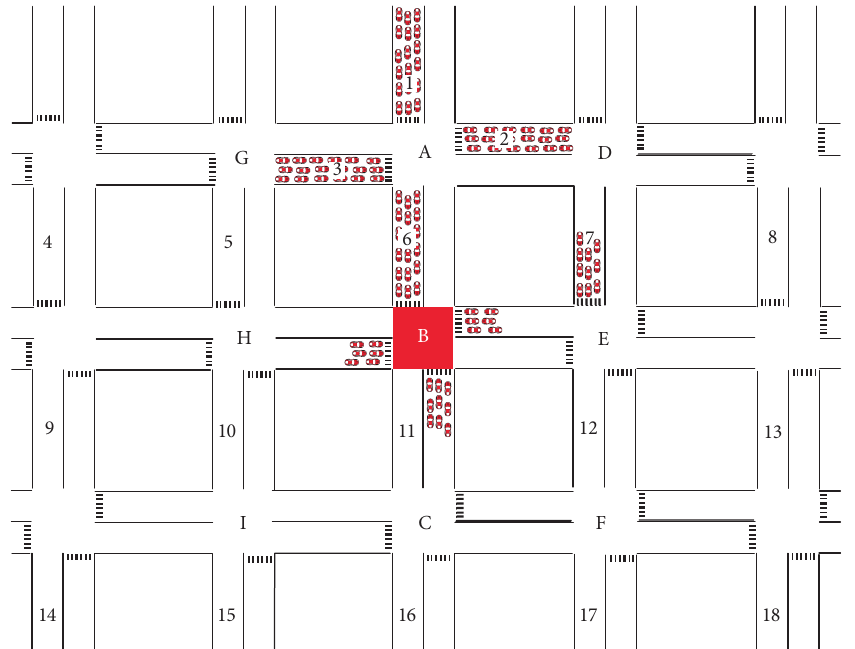
Figure 16: Suppose this network for ETL application. This network has a traffic jam on junction ( B ). As can be seen, node numbers 1, 2, and 3 are traffic jam providers of traffic jam accrued on junction ( B ). Using the ELT, the entrance to link number 6 is prevented until the traffic is dissipated. Using this strategy, drivers on links 1, 2, and 3 change their route to use alternative paths such as links 5 and 7. Accordingly, the traffic distributes uniformly in the network to satisfy the user equilibrium principle in the